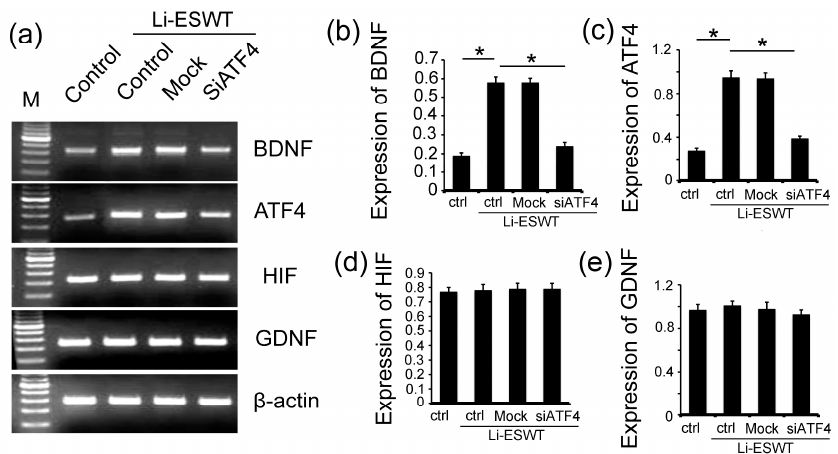
Figure 4. Silencing of ATF4 with siRNA in RT4-D6P2T cells in vitro. ( a ) The expression of BDNF, ATF4, hypoxia-inducible factor (HIF)1 α , and glial cell-derived neurotrophic factor (GDNF) with siRNA and Li-ESWT ( n = 3 in triplicates); ( b ) Silencing of ATF4 eliminated the effect of Li-ESWT on the expression of BDNF ( p < 0.05); ( c ) Silencing of ATF4 eliminated the effect of Li-ESWT on the expression of ATF4 (* p < 0.05); ( d ) siATF4 and Li-ESWT had no effect on HIF1 α (* p > 0.05); ( e ) siATF4 and Li-ESWT had no effect on GDNF (* p > 0.05).